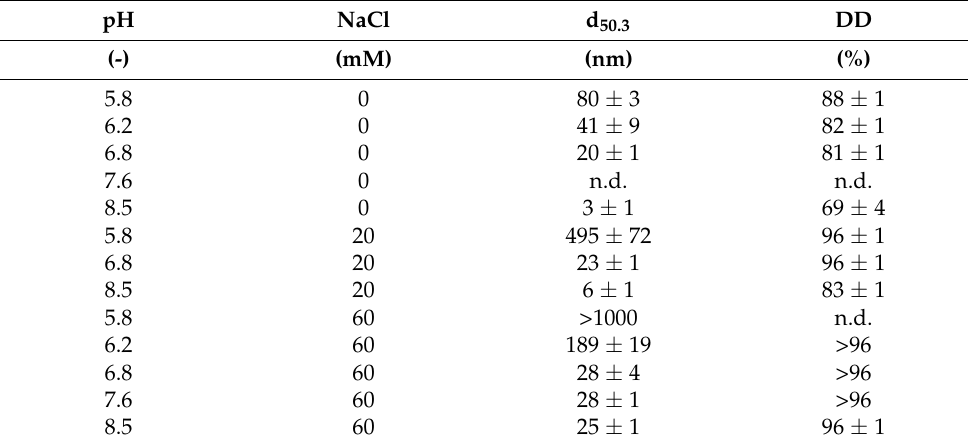
Table 1. Median particle size (d 50.3 ) and degree of denaturation (DD) in dependence of heat- ing pH and NaCl concentration of heat-treated (80 ◦ C/90 min) β -Lg solutions (10 g L − 1 ) (n.d.— not